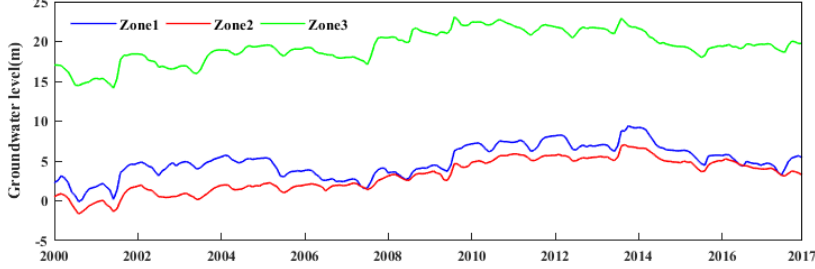
Figure 1. ( a ) Location of Shandong Province in China; ( b ) location of Longkou in Shandong Province; ( c ) description of the study area. Figure 2. Changes of monthly average groundwater level (GWL) in three zones (years 2000–2017).